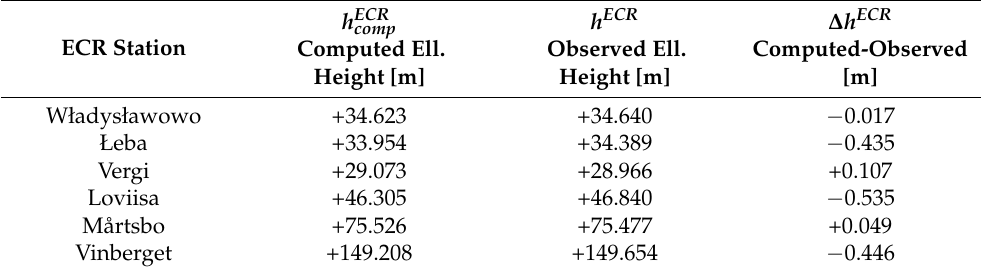
Table 11. Comparison of SAR positioning heights at ECR stations to co-located permanent GNSS station heights. h ECR comp = h GNSS + ∆ h ECR : ellipsoidal height transferred from GNSS to ECR station; GNSS ∆ h ECR : ellipsoidal height difference transferred GNSS versus ECR. ∆ h ECR h ECR comp h ECR ECR Station Computed Ell. Observed Ell. Computed-Observed Height [m] Height [m]